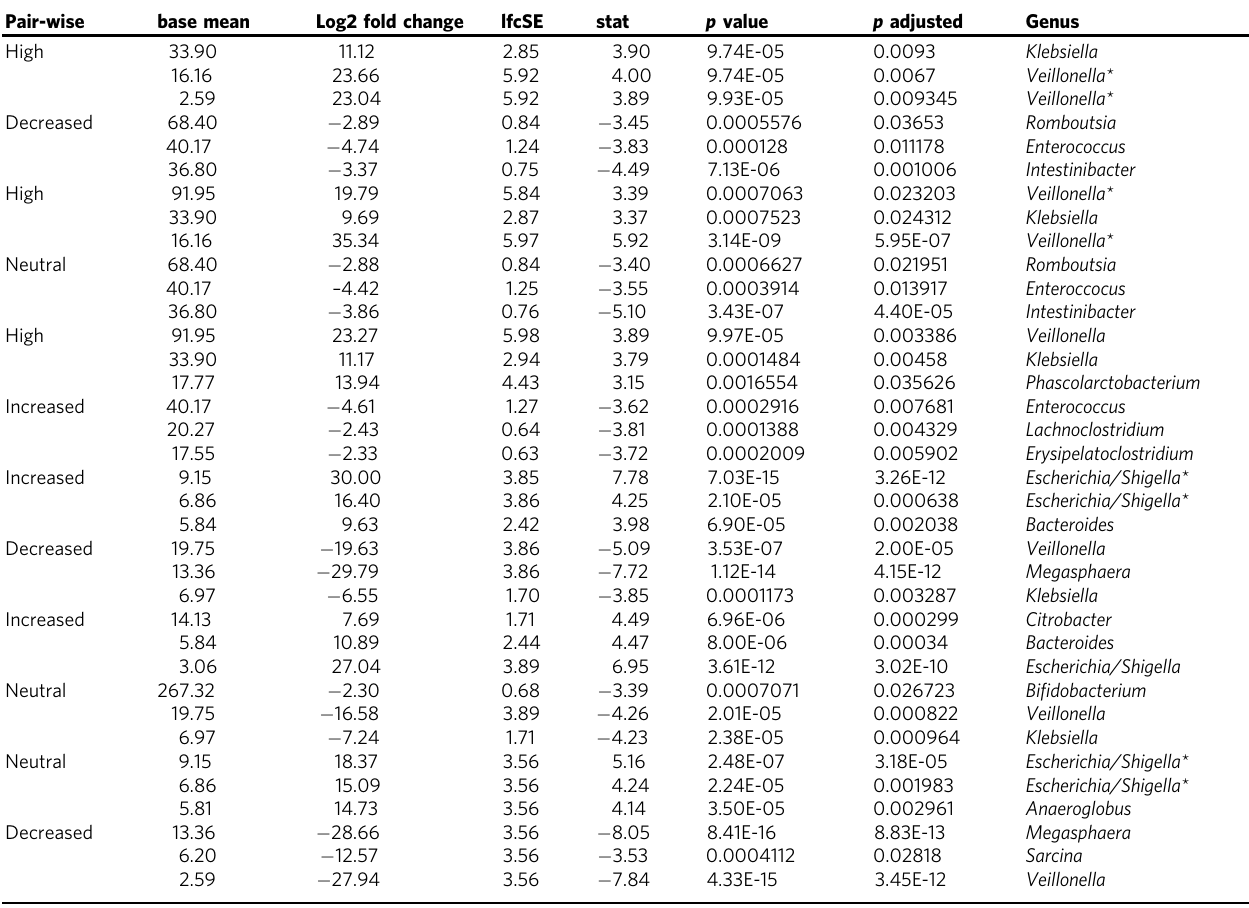
Table 2 DESeq2 supports LEfSe results at the ASV level